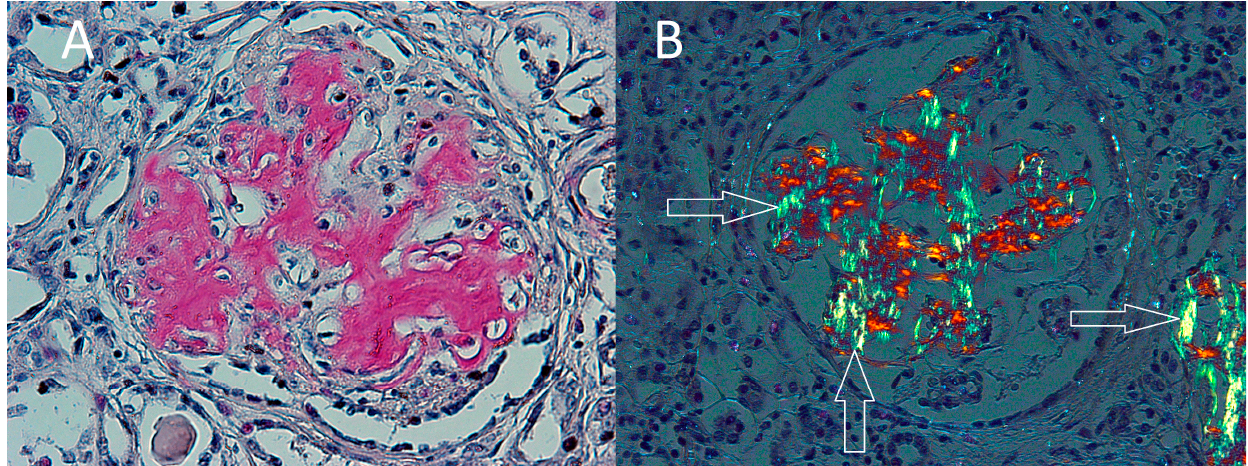
Figure 3. ( A ) Congo red positive deposits in glomerulus of the kidney. Magnification × 200. ( B ) Birefringent particles in the glomerulus and focally in the interstitium presenting a green apple color after staining with Congo red and seen under polarized light (white arrows). Magnification × 200.